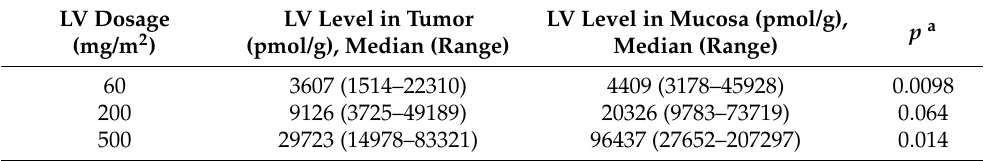
Table 1. Comparison of LV levels in tumor and mucosa of patients treated with two-hour infusion of LV.